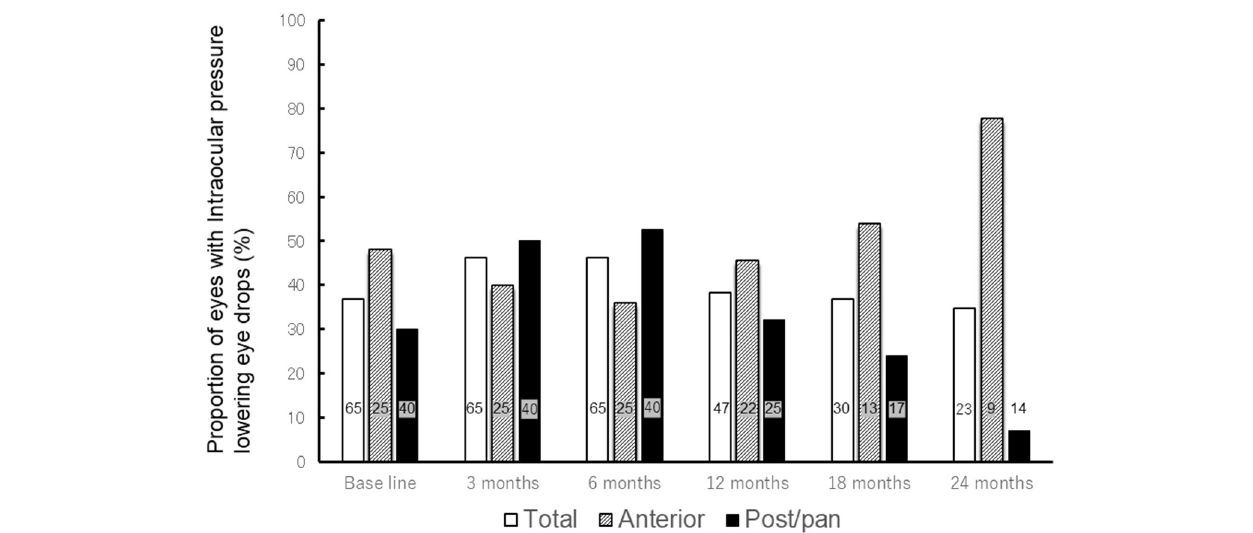
FIGURE 1 | Change in proportion of eyes with intraocular pressure-lowering eye drops after methotrexate therapy. The bar graph shows the change in proportion of eyes with intraocular pressure lowering eye drops after methotrexate treatment (All patients, patients with anterior uveitis, and patients with posterior/panuveitis). The proportion of all eyes with intraocular pressure-lowering eye drops remained between 34.8 and 46.2% throughout methotrexate therapy. While proportion of eyes with intraocular pressure-lowering eye drops decreased from 30.0% at base line to 7.7% at 24 months in patients with posterior/panuveitis, it increased from 48.0% at baseline to 77.8% at 24 months in those with anterior uveitis. The numbers in each bar graph represents the number of eyes using intraocular pressure-lowering eye drops. Total = all patients, Ant = patients with anterior uveitis, Post/pan = patients with posterior/panuveitis.